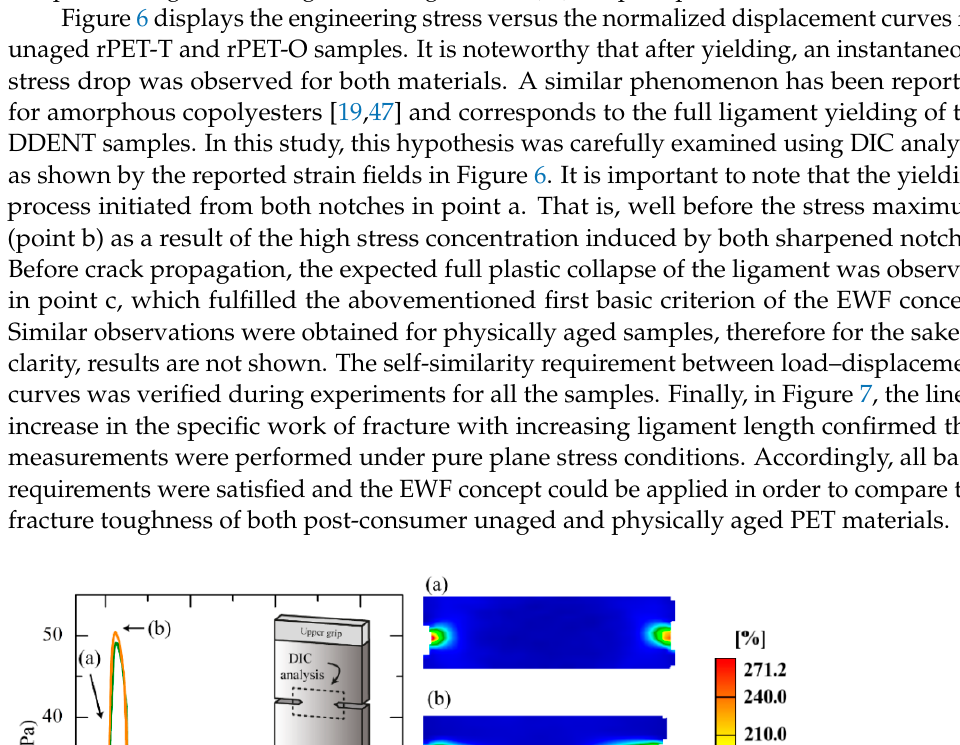
Figure 7. Specific work of fracture as a function of the ligament length for rPET-T and rPET-O ma- terials. The points are experimental data and the lines represent experimental data fits according to Equation (2). Table 5 lists the EWF parameters of unaged and physically aged rPET-T and rPET-O materials obtained at a crosshead rate of 10 mm·min − 1 . For both unaged materials, the high values obtained for both w e and β w p terms are characteristics of tough polymers, as visu- ally confirmed in Figure 8. SEM observations of the fractured surface of unaged DDENT specimens revealed that rPET-T failed by ductile tearing. In contrast the plastic behavior of rPET-O seemed to be governed by different deformation mechanisms. That is, mi- crovoiding is observed in a restricted region at the tip of the notches that in turn triggers latter matrix fibrillation.